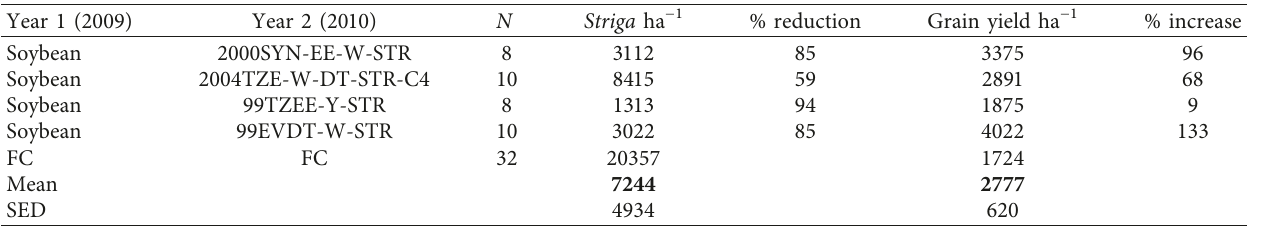
Table 3: Striga count ha − 1 and mean grain yield of different maize varieties following soybean on farmers’ field in Sudan savannah.